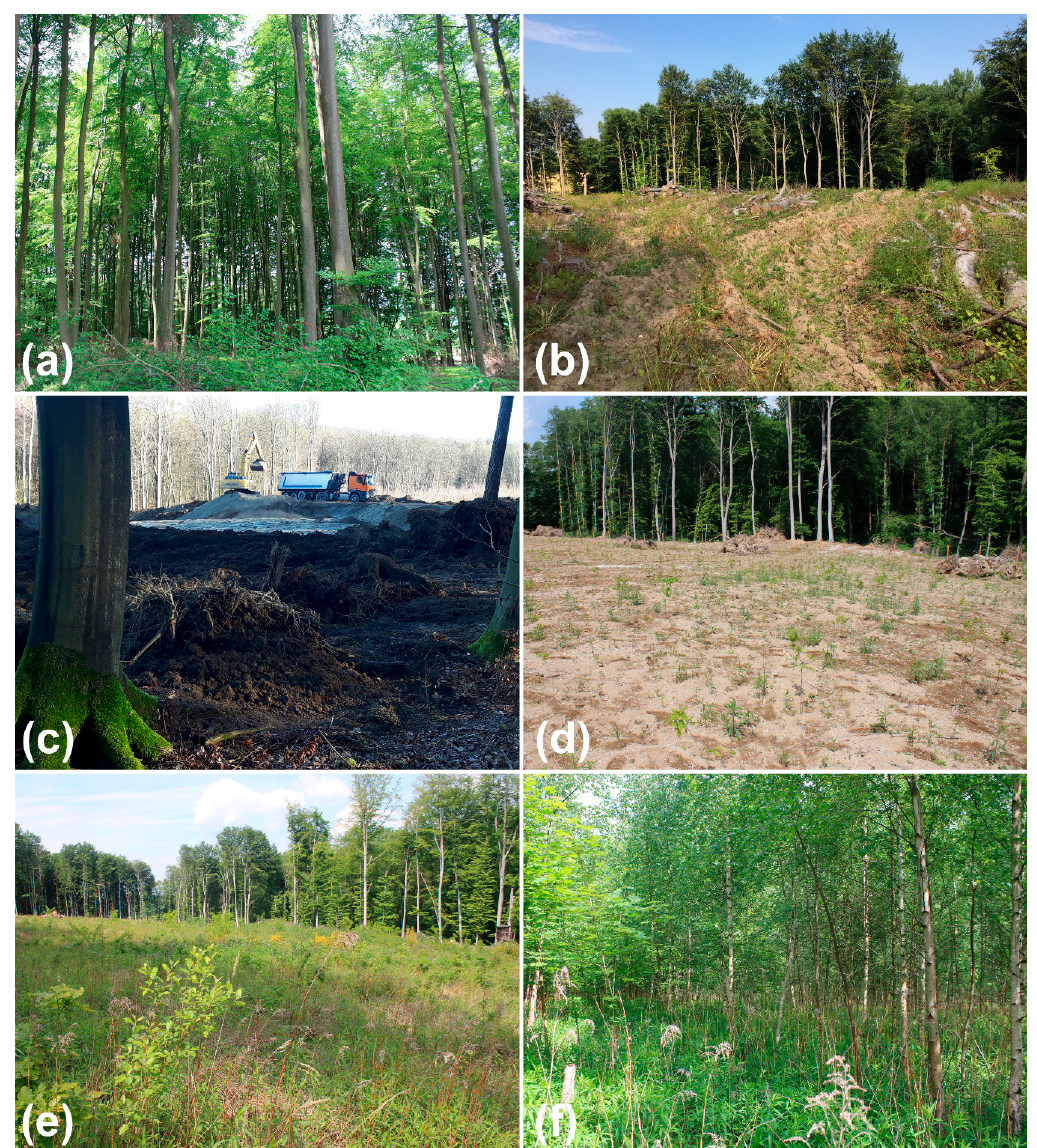
Figure 6. Land management stages: ( a ) undisturbed forest, ( b ) clear-cut, ( c ) excavation works, ( d ) bare surface, ( e ) succession, ( f ) reestablished forest. (Photo 4 ( b ): Alexander Klein). ( b – d ) show excavation works on the same sub-area.